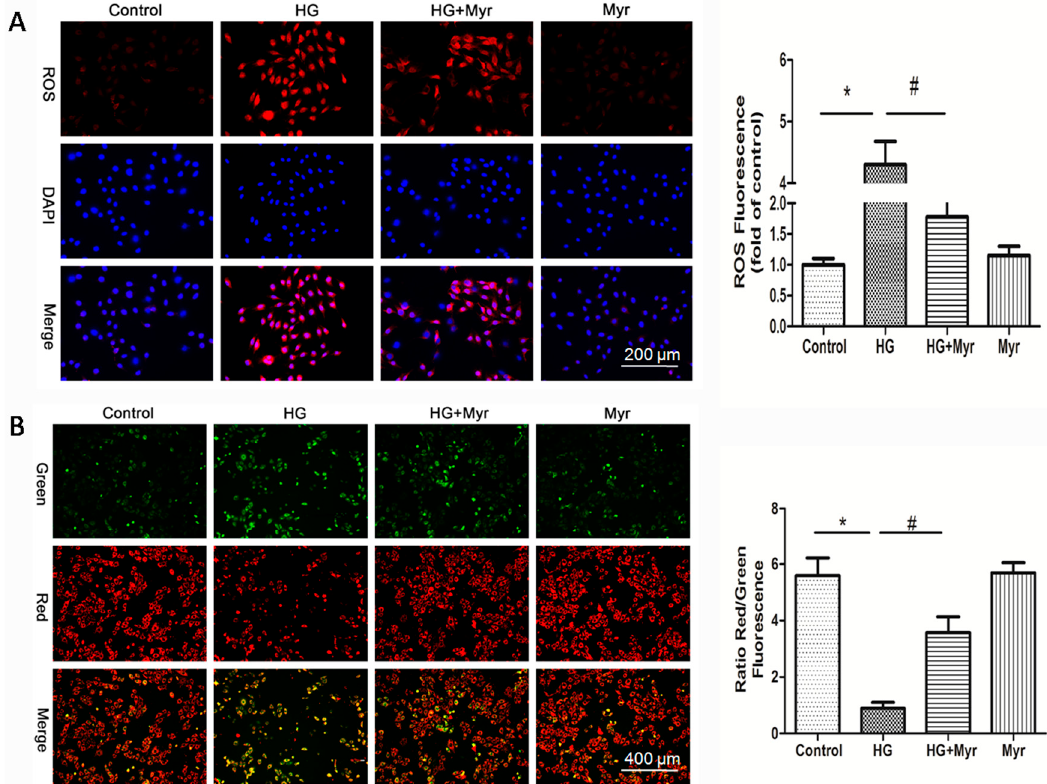
Figure 3. The effects of myricitrin on HG-induced ROS production and MMP ( ΔΨ m) reduction in H9c2 cells. ( A ) Fluorescence images and bar diagram showed the ROS levels in the H9c2 cells; the fluorescence intensity of ROS was measured by a fluorescence microplate reader. The bar represents 200 μ m; ( B ) Representative images and quantitative analysis of JC-1 staining. Treating H9c2 cells with HG caused a significant decrease in the in the ratio of red to green fluorescence intensity, which is a sign of the early stages of cell apoptosis. The bar represents 400 μ m. Values are represented as the mean ± SD; n = 10 wells per group. * p < 0.01 vs. control; # p < 0.01 vs. HG.